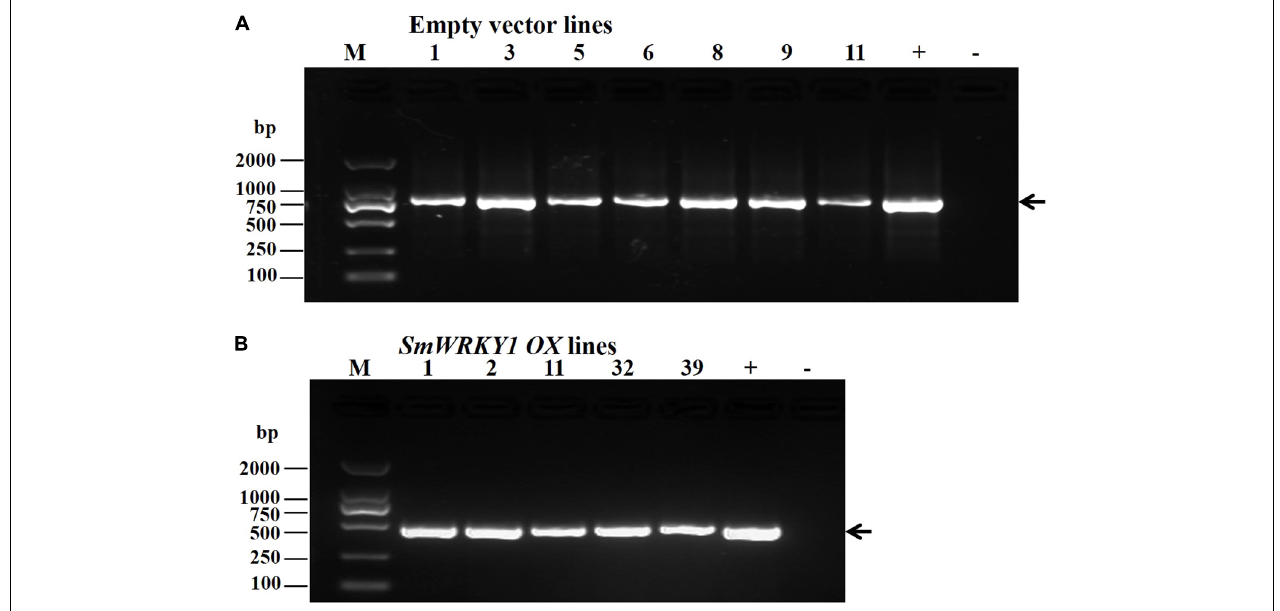
FIGURE 5 | (A) Identification of positive transgenic hairy root lines by PCR. ( GusA- F and GusA- R were used to identify empty vector pCAMBIA2300 sm transformed lines (B) Primers CaMV35S -F23 and SmWRKY1- QR were used to identify the positive colony of SmWRKY1 overexpression transgenic